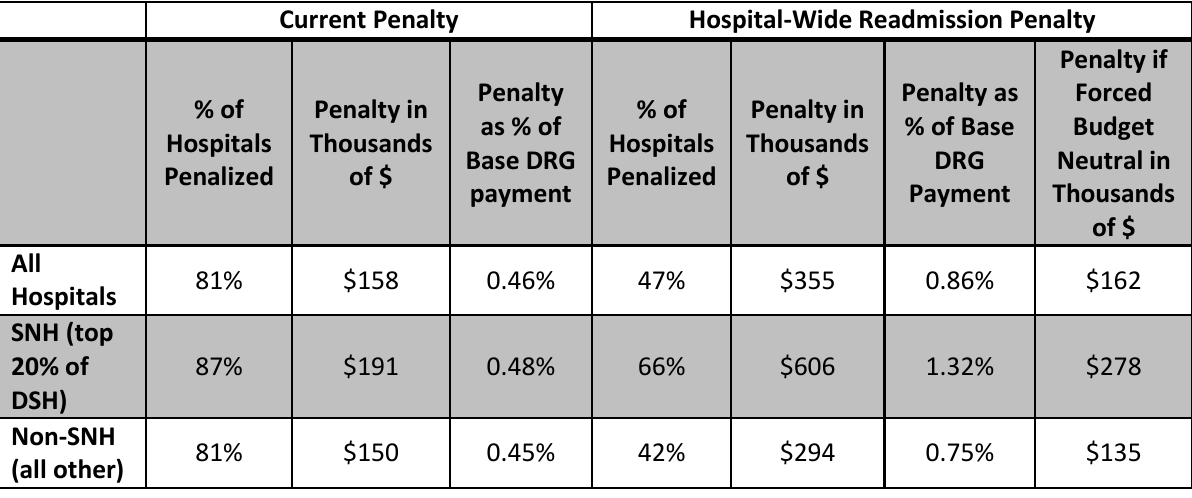
Table 5.13. Results of Moving to a Hospital-Wide Readmission